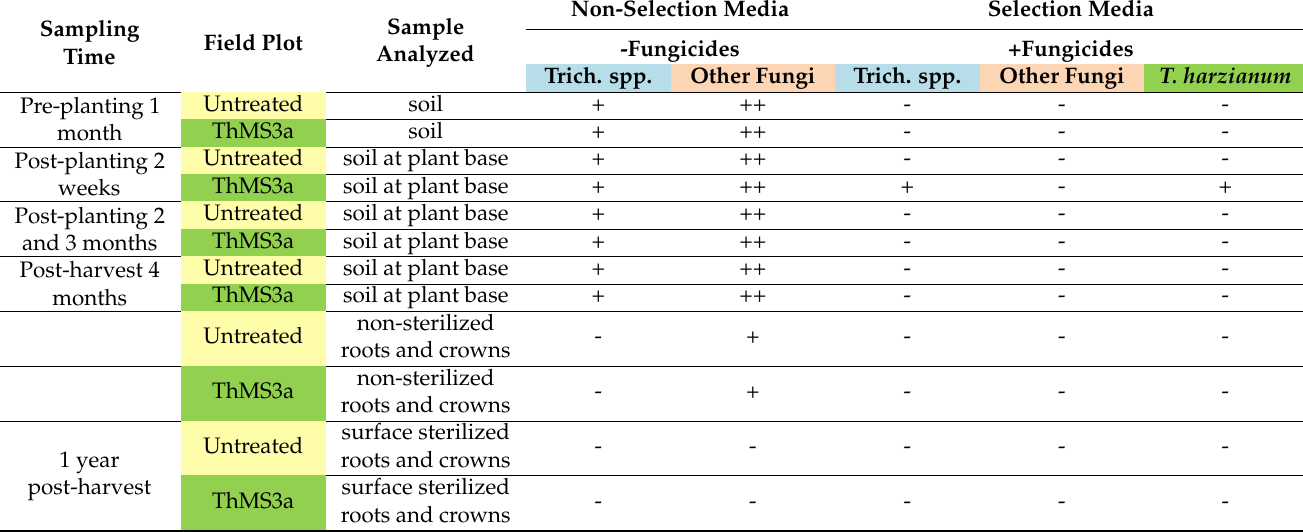
Table 3. Yakima soil analysis for the detection of fungicide resistant T. harzianum